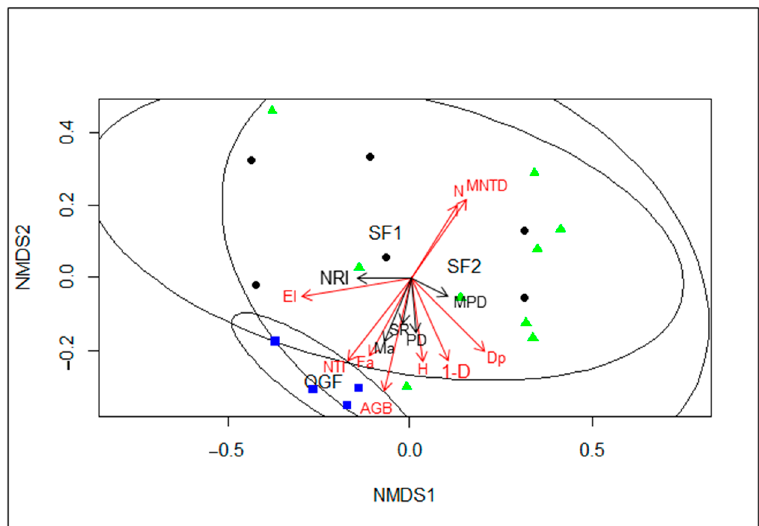
Figure 3. NMDS ordination showing dissimilarities of the compositional structure of the forest types in ellipses: OGF: Old-growth forests (blue squares); SF1:-secondary forests (green triangles); SF2:-secondary forests (black circles) with stress value = 0.09. Significant variables ( p < 0.05) are displayed in red arrows and nonsignificant variables ( p > 0.05) in black arrows. N: number of individuals, SR: species richness; H: Shannon, (1-D): Simpson, Ma: Margalef, and Fa: Fisher